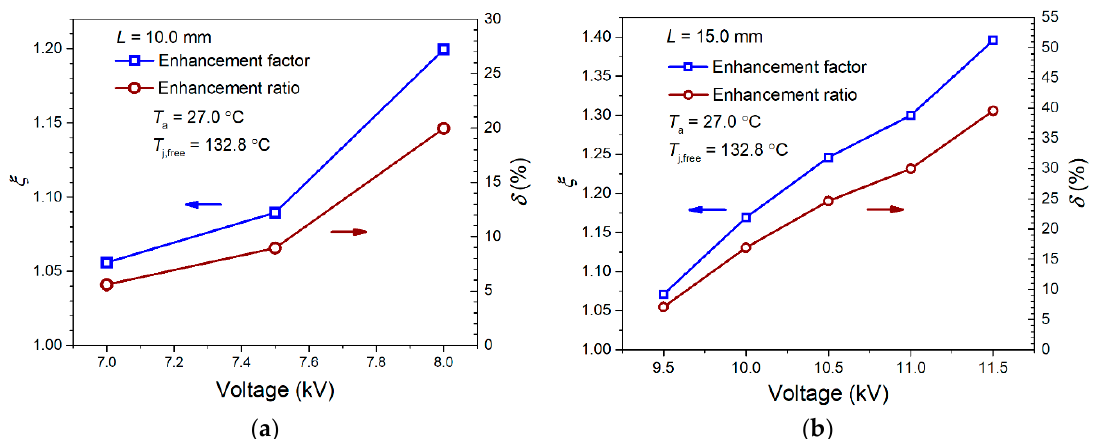
Figure 7. Enhancement factor and ratio according to applied voltage under different electrode gaps: ( a ) electrode gap of 10.0 mm; and, ( b ) electrode gap of 15.0 mm.